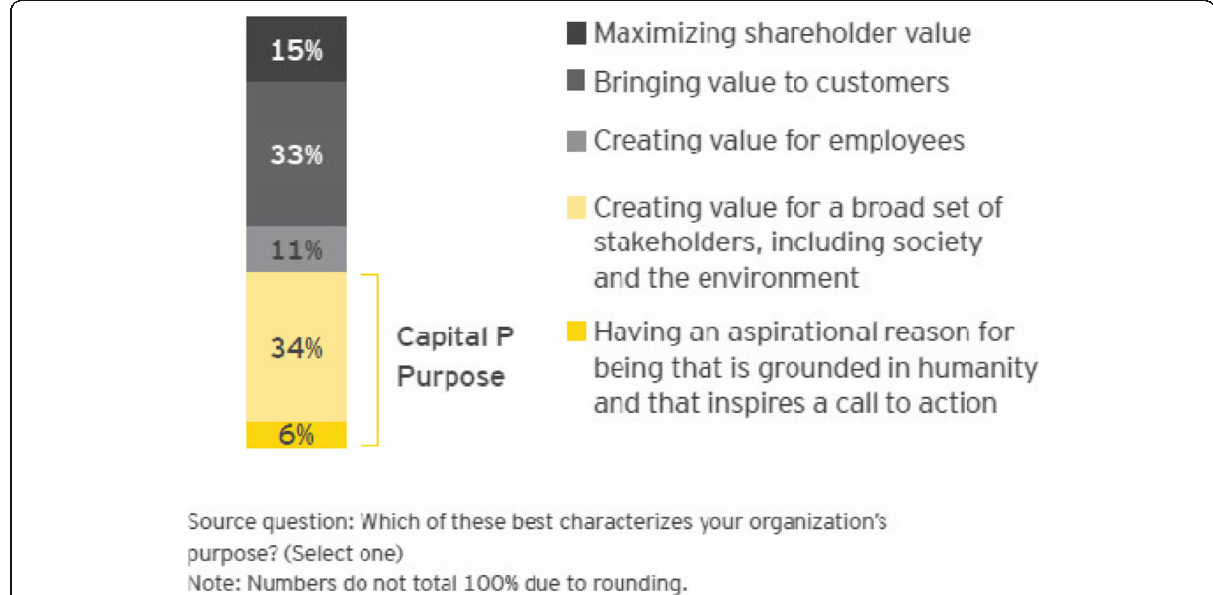
Fig. 1 The Definitions of Purpose. Source: EY Beacon Institute, “ How Can Purpose Reveal a Path through Disruption? Mapping the Journey from Rhetoric to Reality ” , report